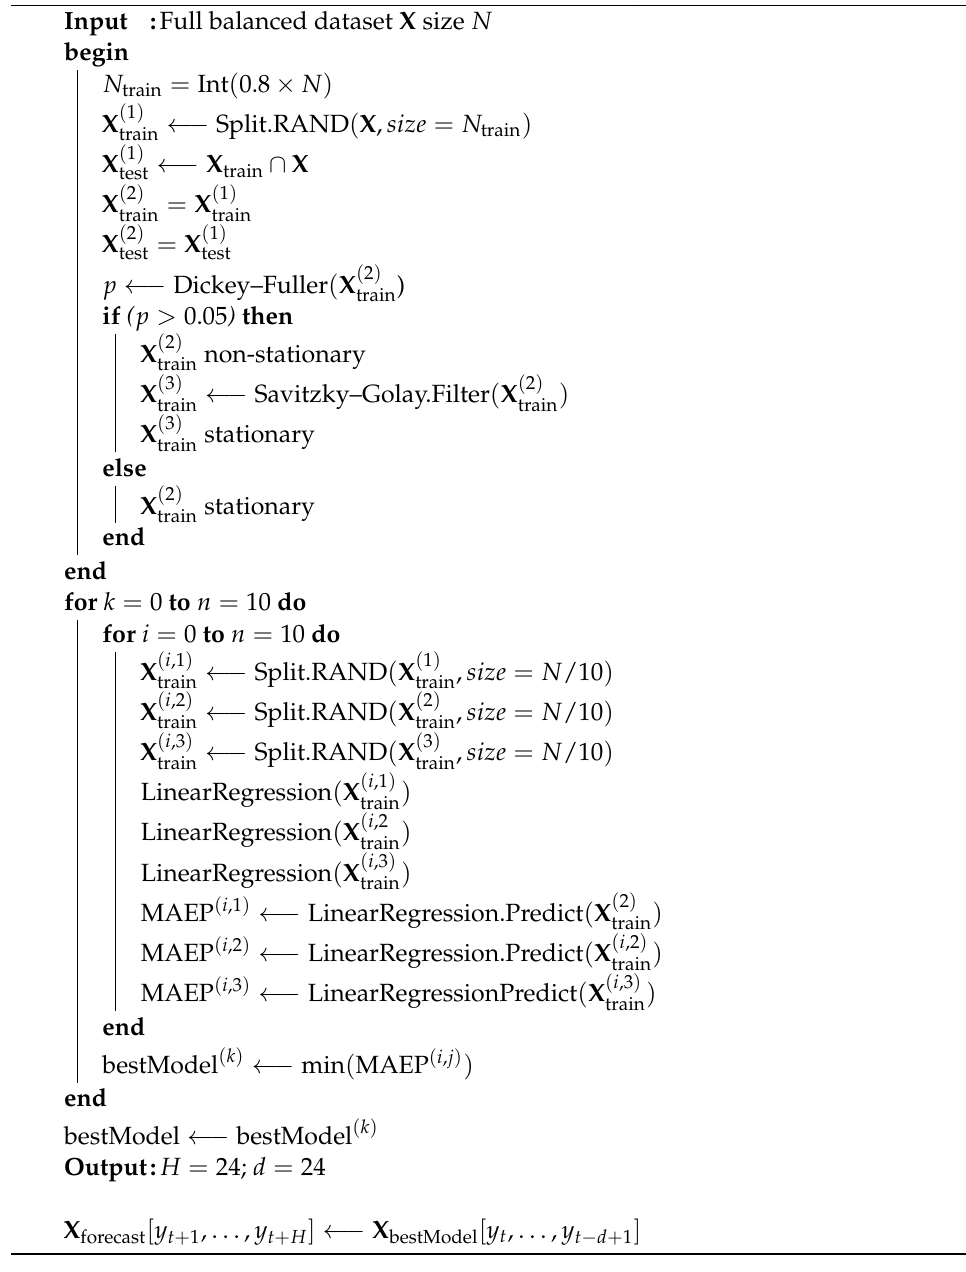
Algorithm 1: Multiple-input multiple-output linear regression